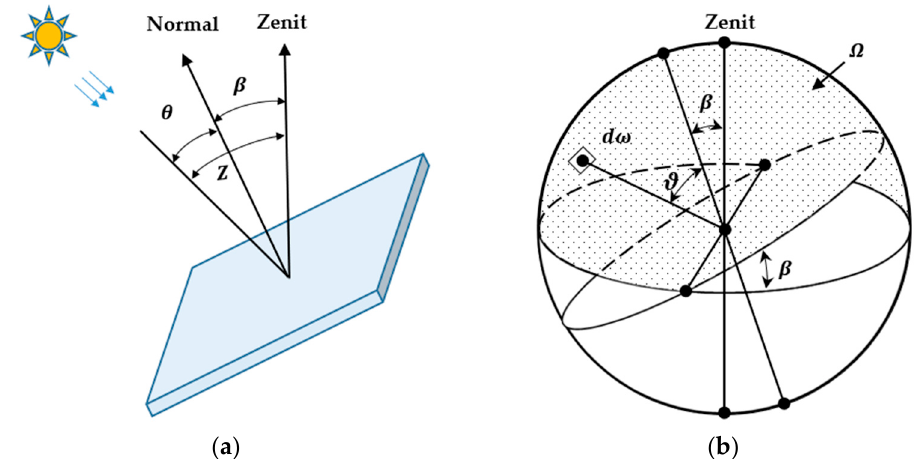
Figure 2. Angles of direct and diffuse light falling on solar panel. ( a ) The angles of direct incidence; ( b ) The angles of diffuse incidence.